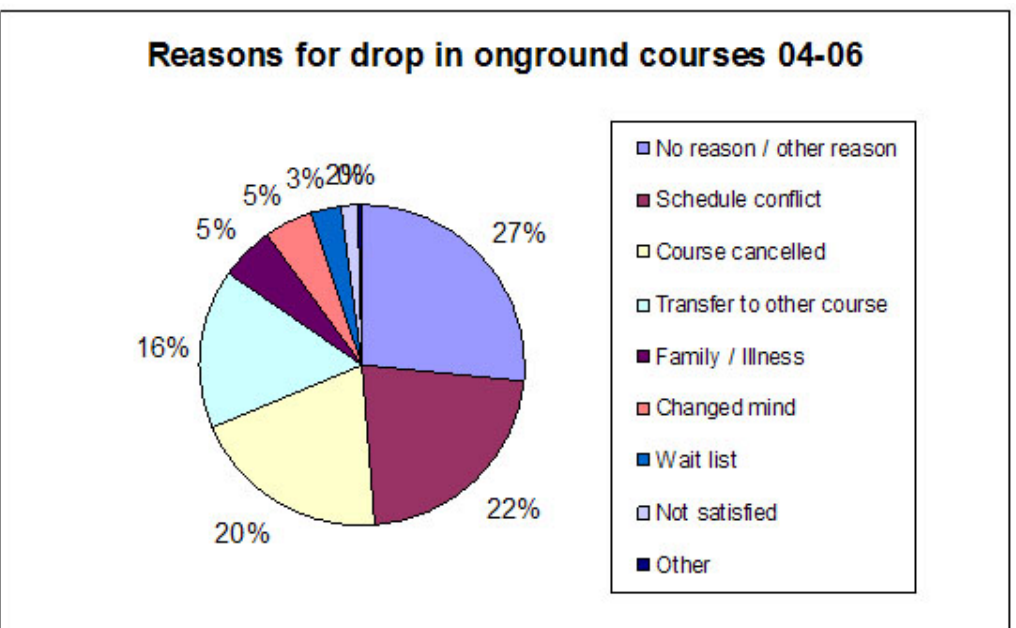
Collapsing the top categories as was carried out for the online courses, we get: Figure 4 . Distribution of drop reasons in onground courses (top 9